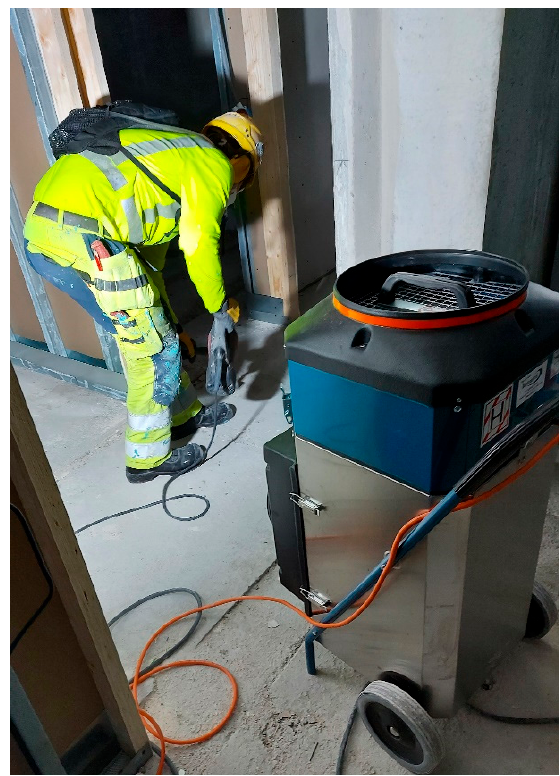
Figure 1. Using a mobile air cleaner to lower dust exhausts to general air from a hand-held jackhammer with a blade. Reproduced with permission from Tuomi et al., Finnish Institute of Occupational Health, 2022 [34].